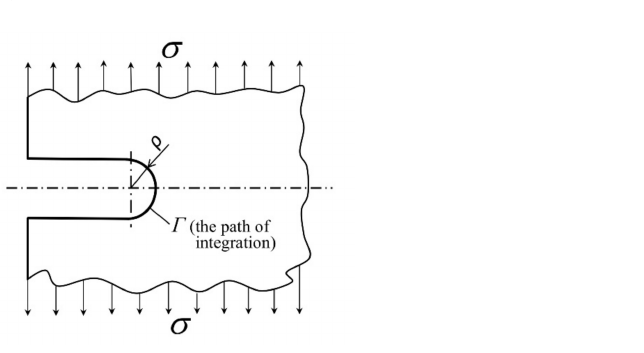
Figure 1. A section of a notched body, loaded by a remote uniform stress, and an indication of the path of integration.